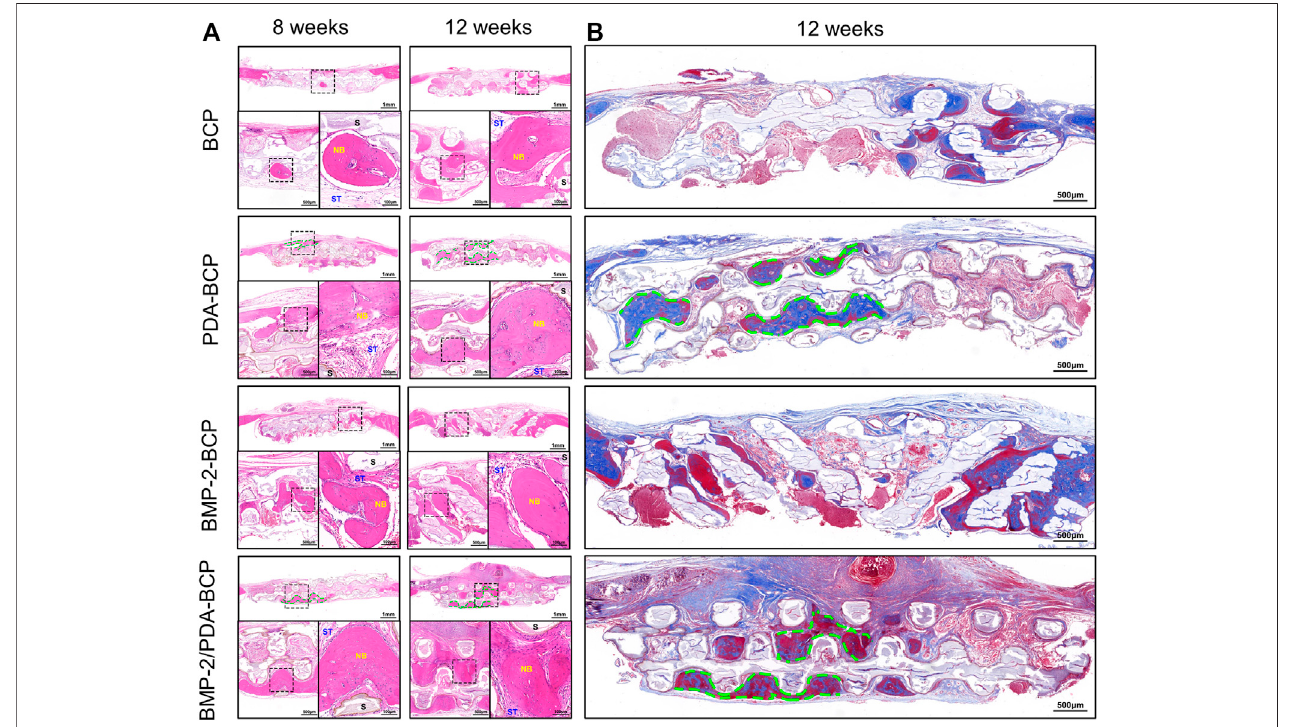
FIGURE 8 | Histological evaluation of new bone formation in the critical-size bone defect model of SD rats after 8 and 12 weeks. (A) Representative full image of H&E staining of cranial bone defects. Original magni fi cation: 10×, 30×, 100×; scale bar = 1 mm, 500 μ m, 100 μ m. Green dotted line: continuous new bones; NB: newly formed bone; ST: soft tissue; S: scaffolds. (B) Full images of Masson ’ s trichrome staining of decalci fi ed bone in the defect area. Original magni fi cation ×20; scale bar = 500 μ